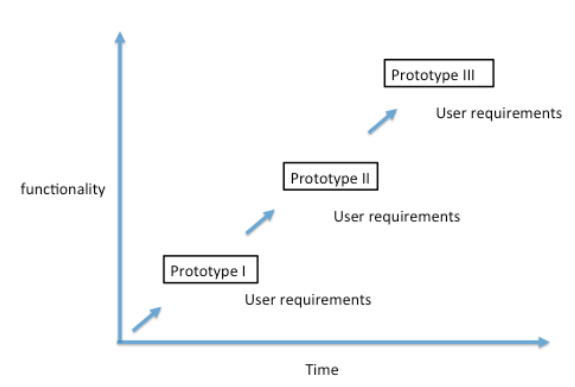
Figure 2: Co-design Prototyping Approach for 3D Precinct Planning Tool Development.